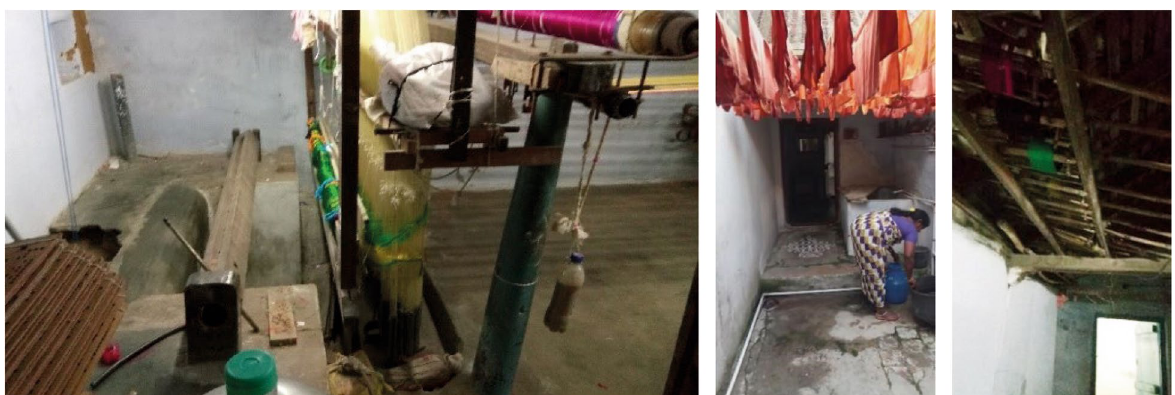
Fig. 18 Details of the single-family dwelling (Source: the